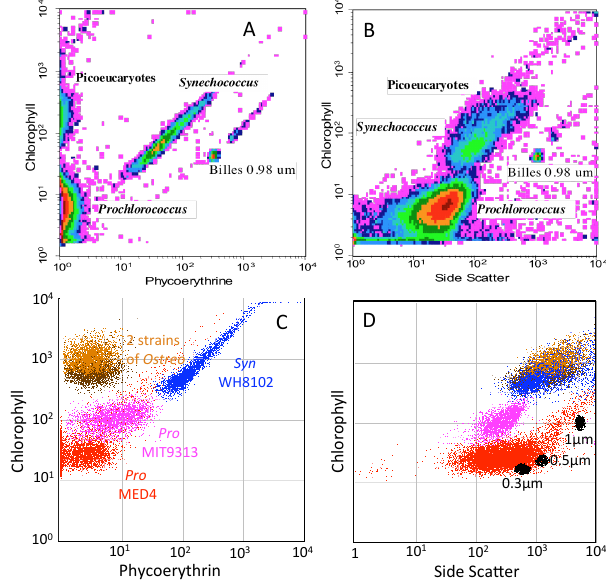
Fig. 5. (A, B) FCM plots of marine picoplankton (Marie et al., 1999); (C, D) this work: cultures of Pro , Syn and Ostreo , with the same colour codes for D as for C and with 0.3µm, 0.5µm and 1µm beads included with the